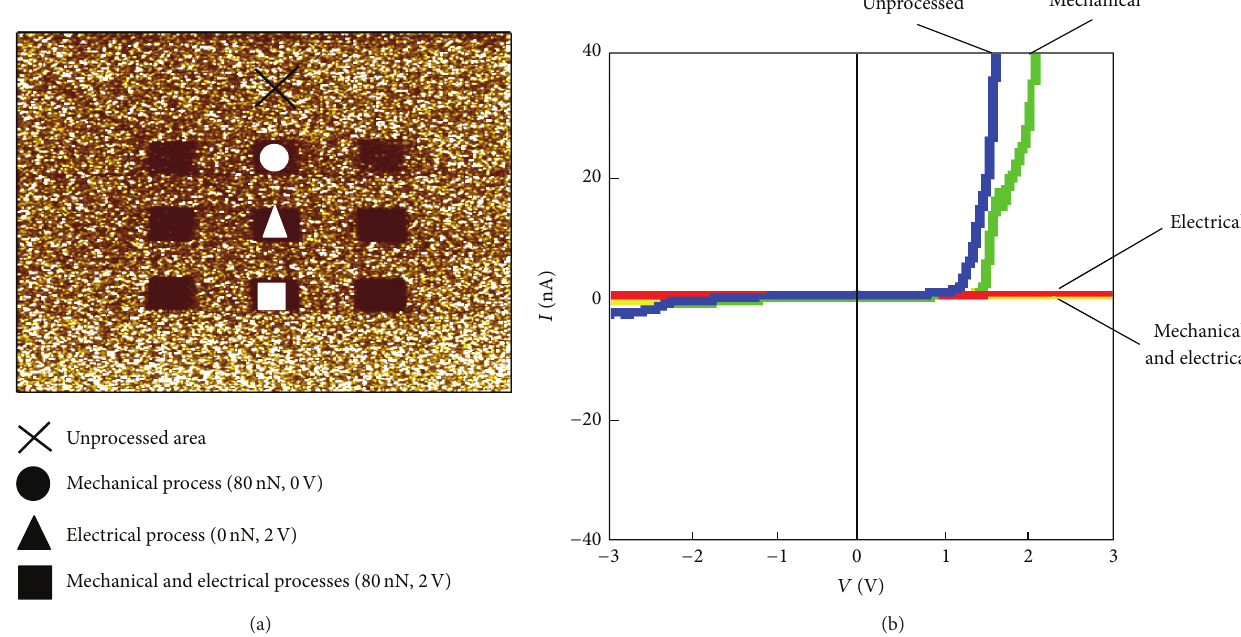
Figure 23: Surface morphology and I-V characteristics of areas processed at different loads and voltages of (closed circle) 80 nN, 0 V, (closed triangle) 0 nN, 2 V, and (closed square) 80 nN,